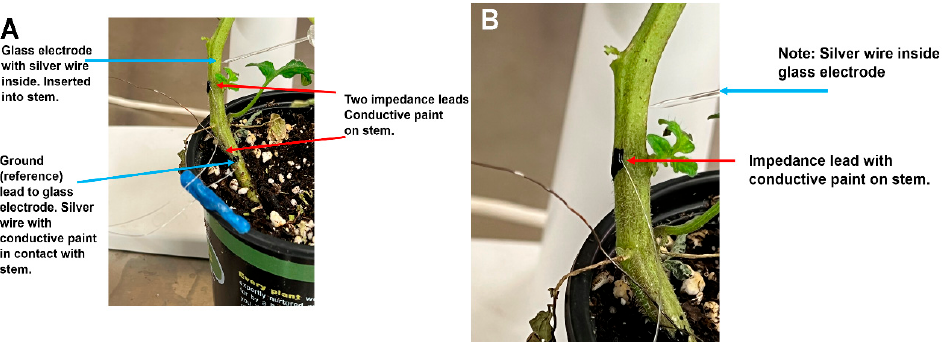
Figure 2. ( A ) Illustration of the simultaneous recording approach of an intracellular glass electrode and reference lead as well as an approach used for a surface recording along the stem of a tomato plant with impedance. ( B ) An enlarged view of the glass microelectrode placed inside the stem with the silver wire inside the glass electrode and one of the impedance leads attached to the surface of the stem with conductive